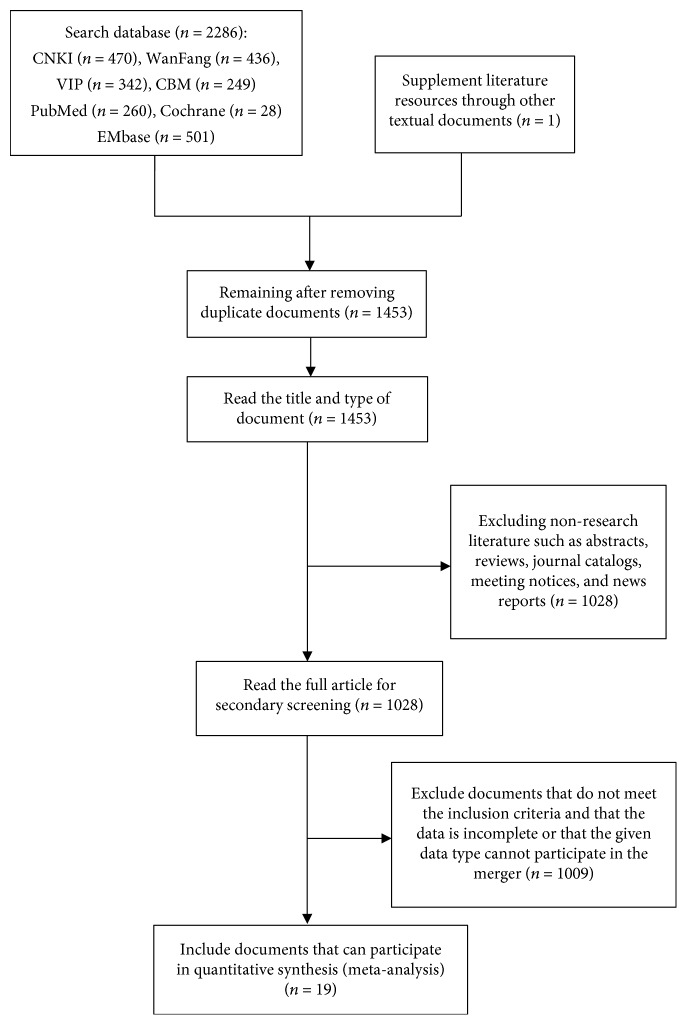
Literature screening process.